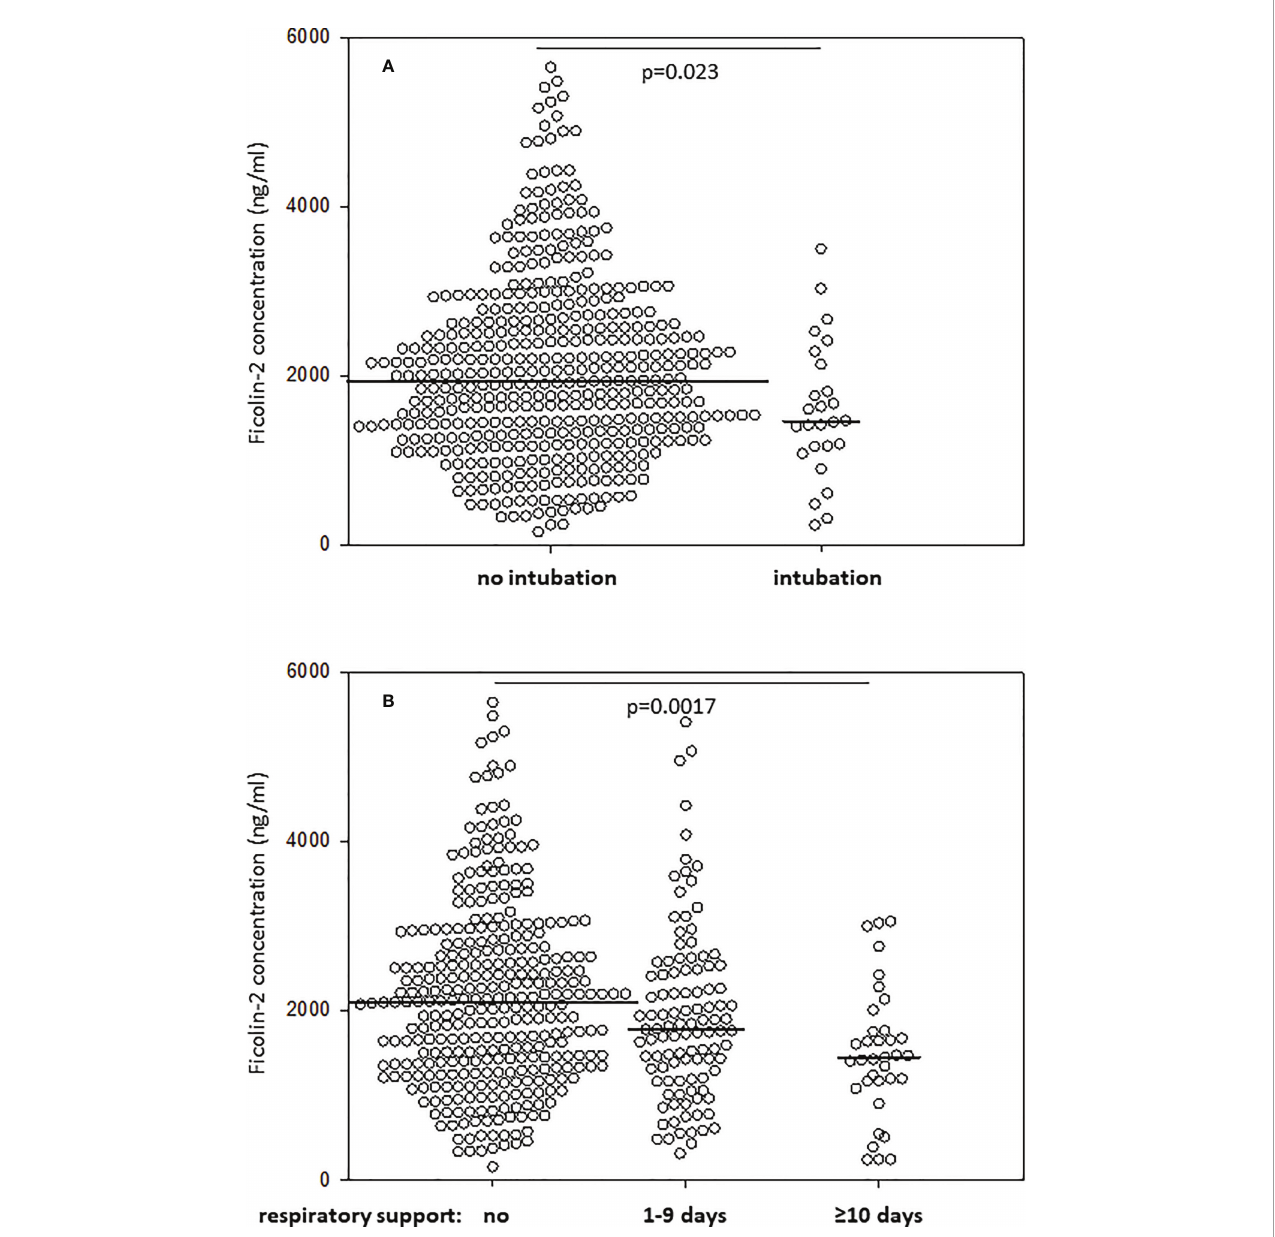
FIGURE 2 Comparison of fi colin-2 concentration in neonates requiring and not requiring intubation at delivery room (A) and/or respiratory support (mechanical ventilation, CPAP, or both) (B) . The horizontal lines mark median values. Medians were compared with the use of Mann-Whitney U test (A) and Kruskal- Wallis test (p=0.001) with post-hoc Dunn test (B)